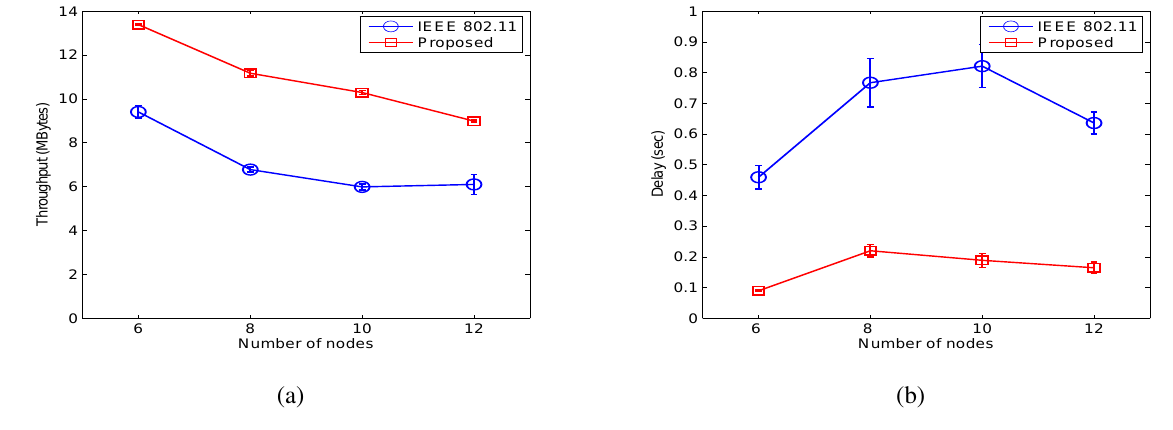
Figure 7. Simulation results for chain networks when σ (b)